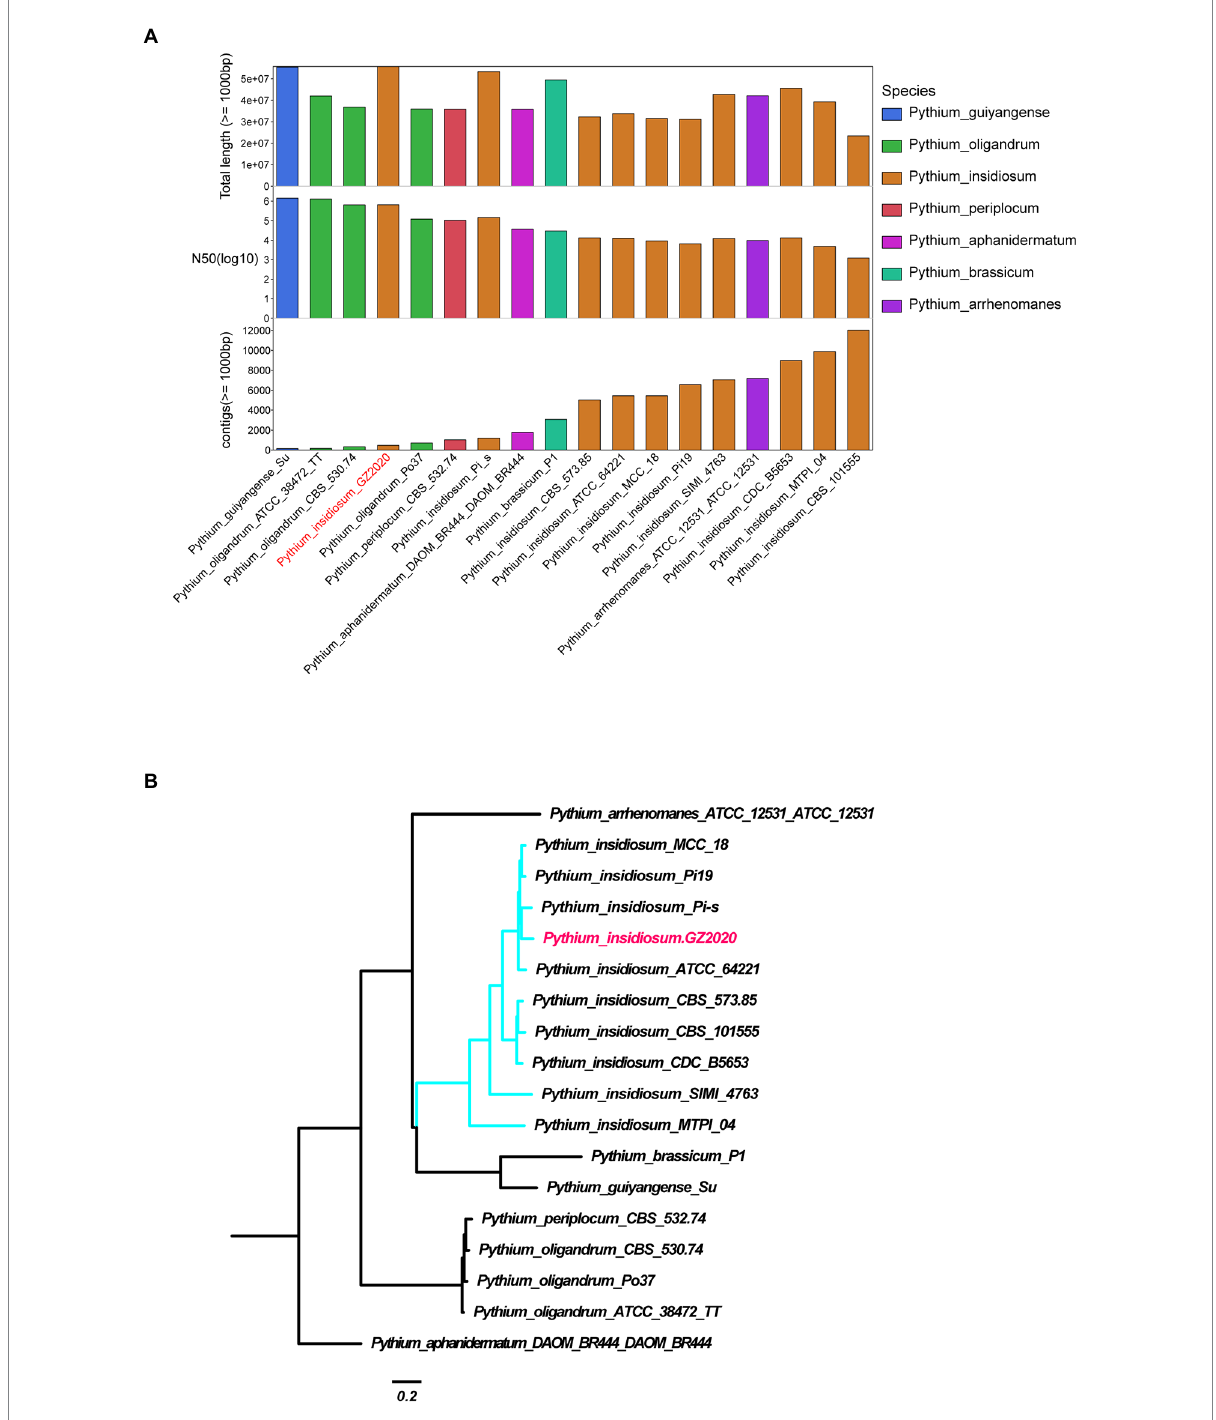
FIGURE 2 Identification of Pythium insidiosum. (A) Comparison of the assembly quality of Pythium strains reported on NCBI and GZ2020. Longer total length, N50, and lower number of contigs reflect better assembly. (B) Genome-wide SNP system tree. Mummer software was used to conduct SNP calling (Pythium aphanidermatum as reference strain) and to construct phylogenetic tree using all SNP